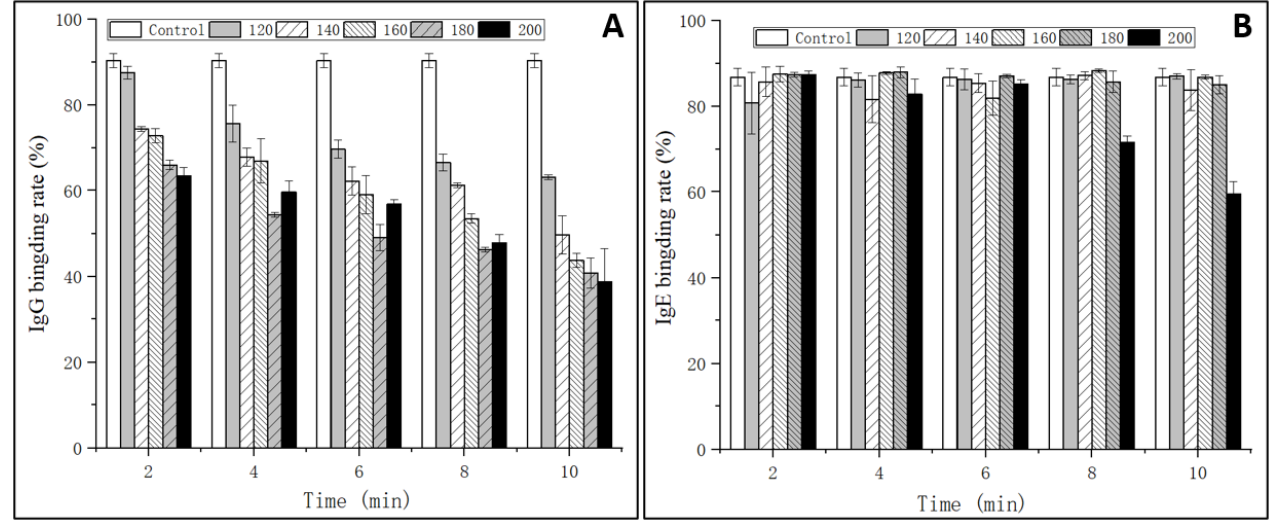
Figure 1. IgG ( A ) and IgE ( B ) binding rates of OVM treated by SS at different temperatures and times.